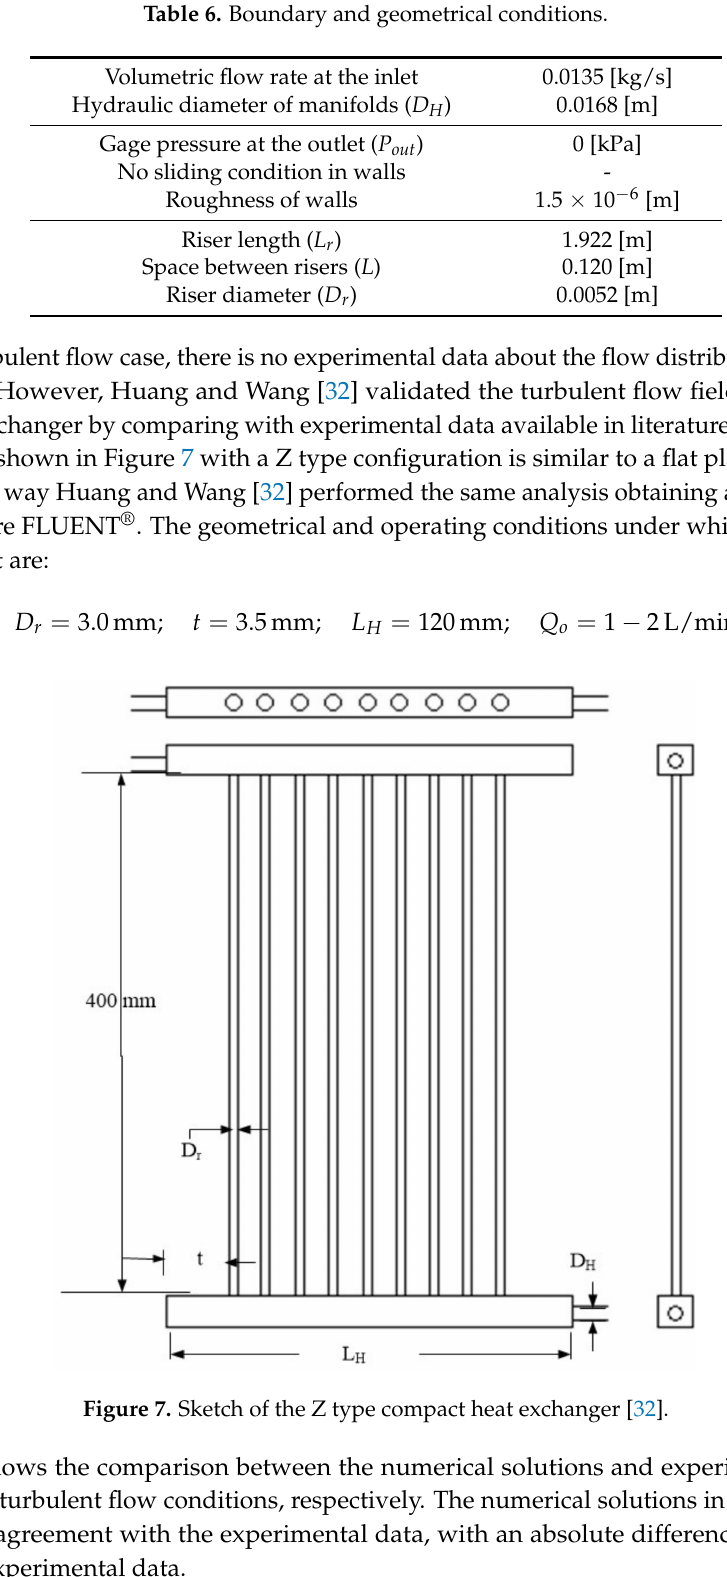
Table 6. Boundary and geometrical conditions.